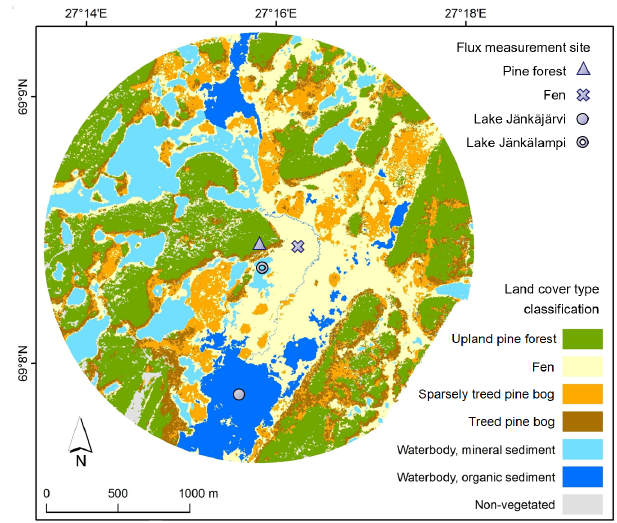
Figure 1. The study area in Kaamanen with land cover type classi- fication and flux measurement site locations.